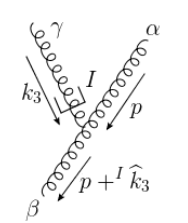
(cid:16) (cid:17) (cid:13) p; I b k 3 (cid:1) (cid:12) I(cid:13) 0 (cid:12) that appears in t (cid:27) A , where only the I joins the gluon with momentum p (cid:22) . Also, the vector index (cid:13) 3 -component according to the same hard-collinear I